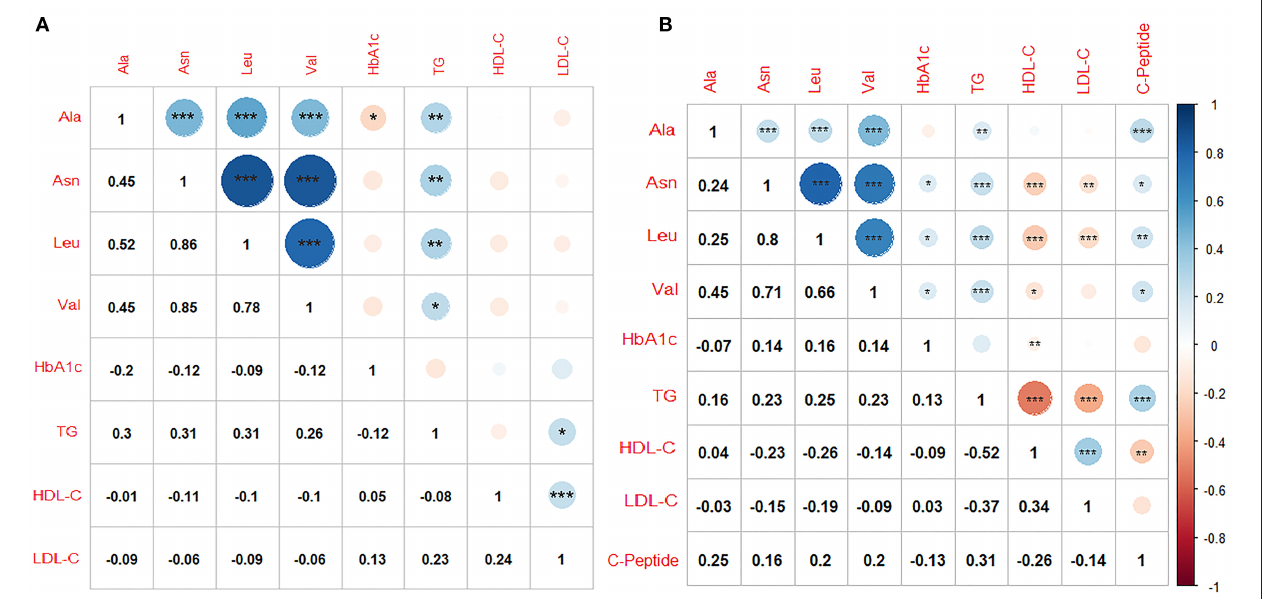
FIGURE 4 | Correlations within metabolites and clinical biochemical parameters. (A) Liaoning Medical University First Affiliated Hospital; (B) the Second affiliated hospital of Dalian Medical University. Ala, Alanine; Asn, Asparagine; Leu, Leucine; Val, Valine; TG, triglyceride; LDL-C, low-density lipoprotein cholesterol; HDL-C, high-density lipoprotein cholesterol; HbA1c, glycated hemoglobin; Color blue, positive correlation coefficients; color red, negative correlation coefficients; Pearson or Spearman correlation was used to calculate the correlation coefficients; * P < 0.05; ** P < 0.01; *** P <